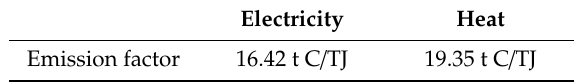
Table A9. The carbon emission factors of electricity and heat in